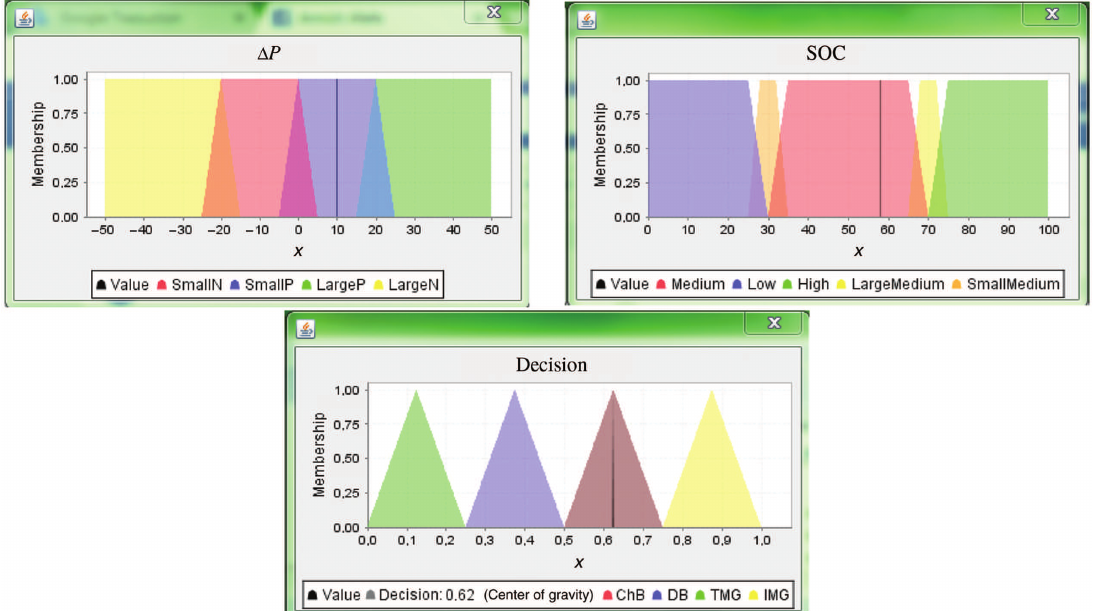
Figure 8: MF for the Input and the Output